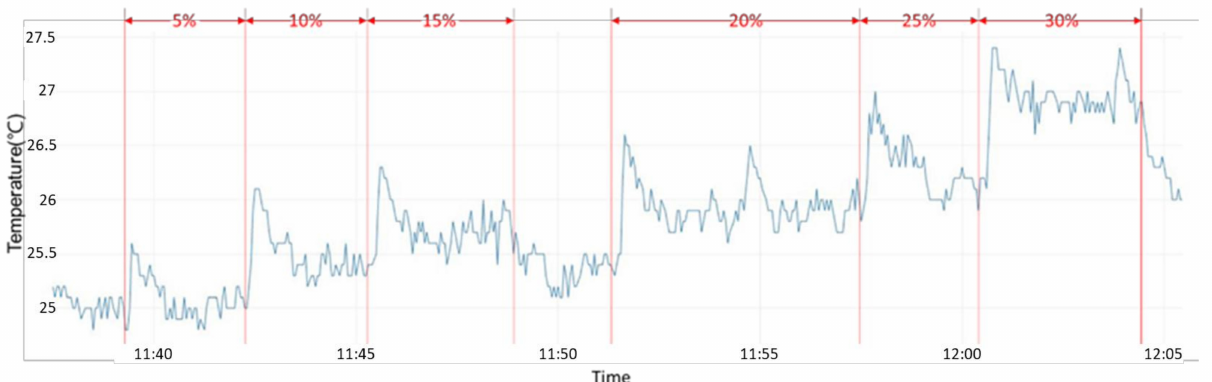
Figure 24. Temperature trend at the point of